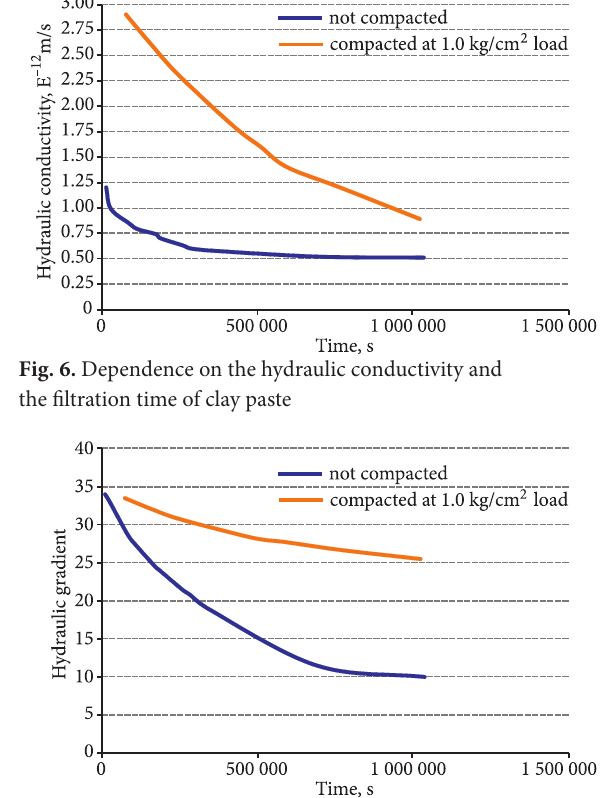
Fig. 7. Dependence on the hydraulic gradient and the filtration time of clay paste